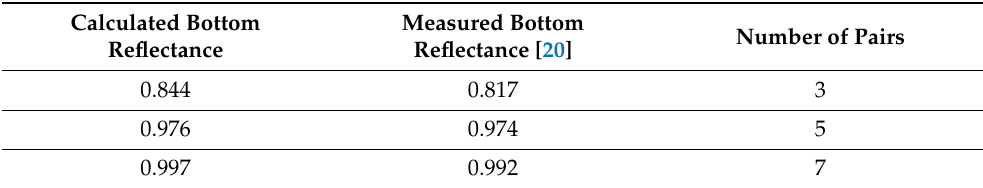
Table 4. The measured and calculated bottom reflectance at 550 nm of the device fabricated by Kitabayashi et al. [20] with different pairs of ZnS/CaF 2